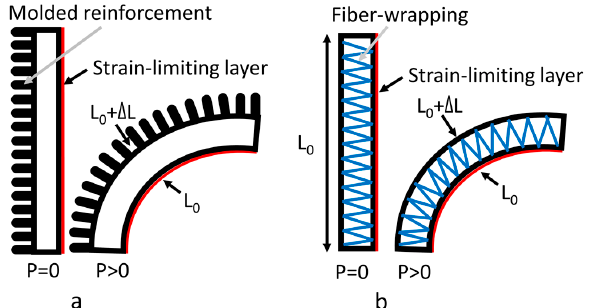
Figure 1. Working principle of soft bending actuators. ( a ) Monolithic polymer construction; ( b ) Fiber- reinforced bending